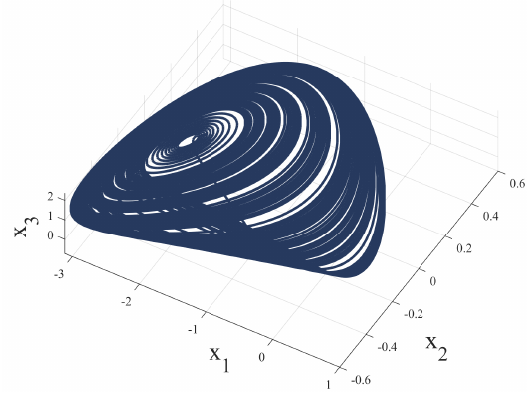
Figure 4. The chaotic attractor for the Chua circuit.